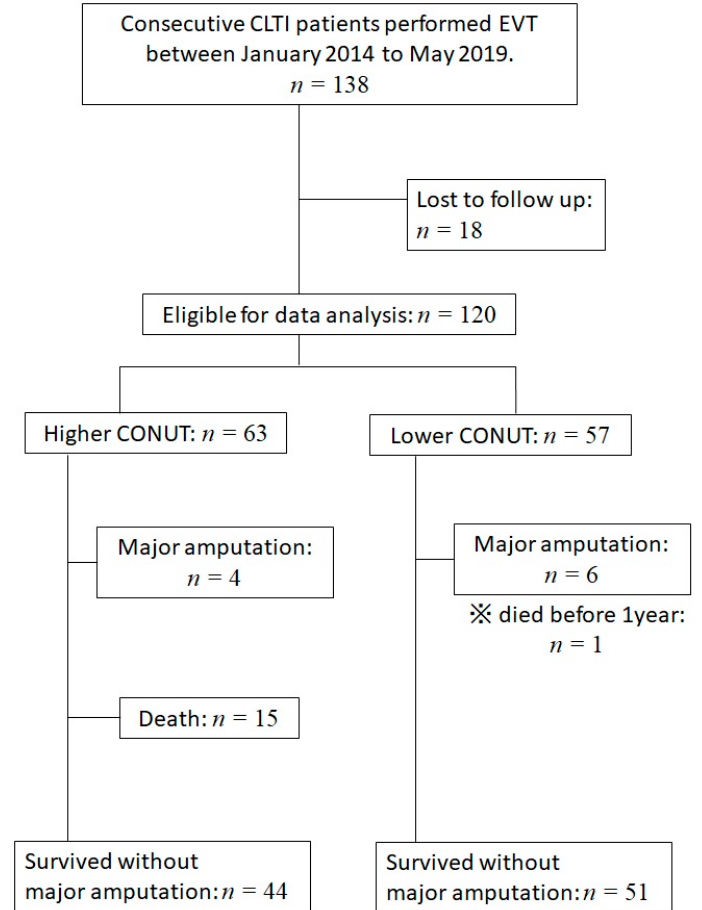
Figure 1. Flowchart of the patient enrollment process. One-hundred thirty-eight patients were enrolled. Eighteen were excluded due to loss of follow up. The analysis was performed on the remaining 120 patients. Abbreviations: CLTI, chronic limb - threatening ischemia; EVT, endovascular therapy; CONUT, controlled nutritional status.